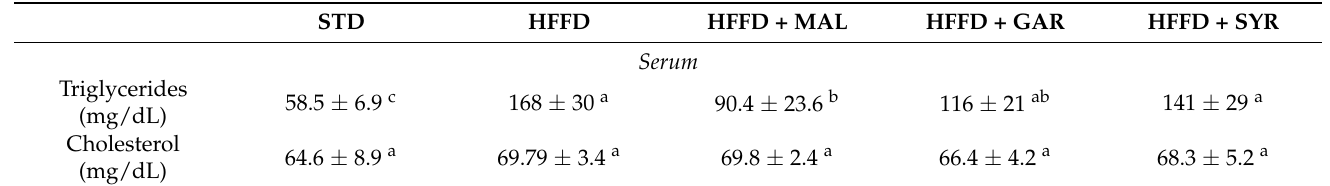
Table 3. Serum triglyceride and cholesterol levels of rats fed a high-fat high-fructose diet supple- mented with different varieties of grape